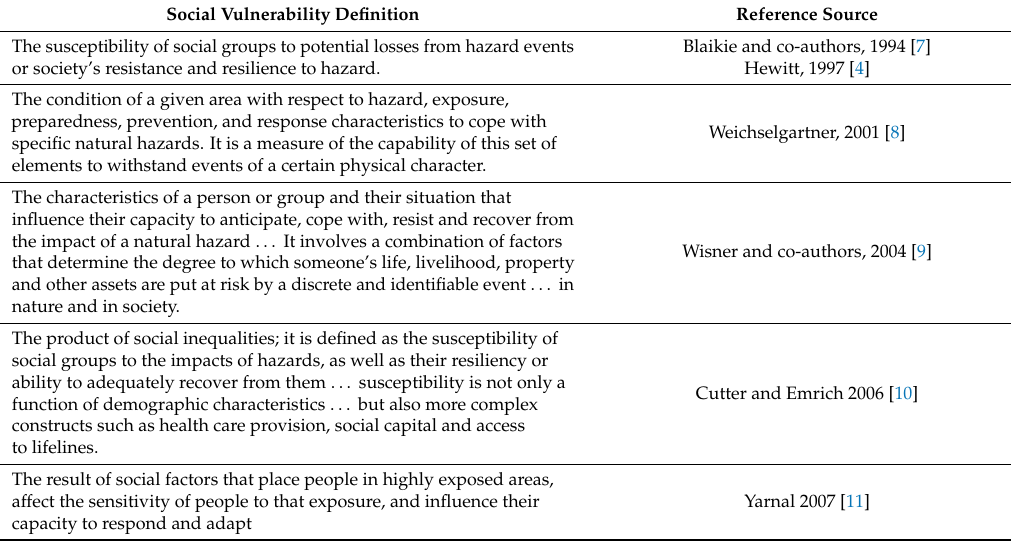
Table 1. Different meanings associated to social vulnerability (adapted from